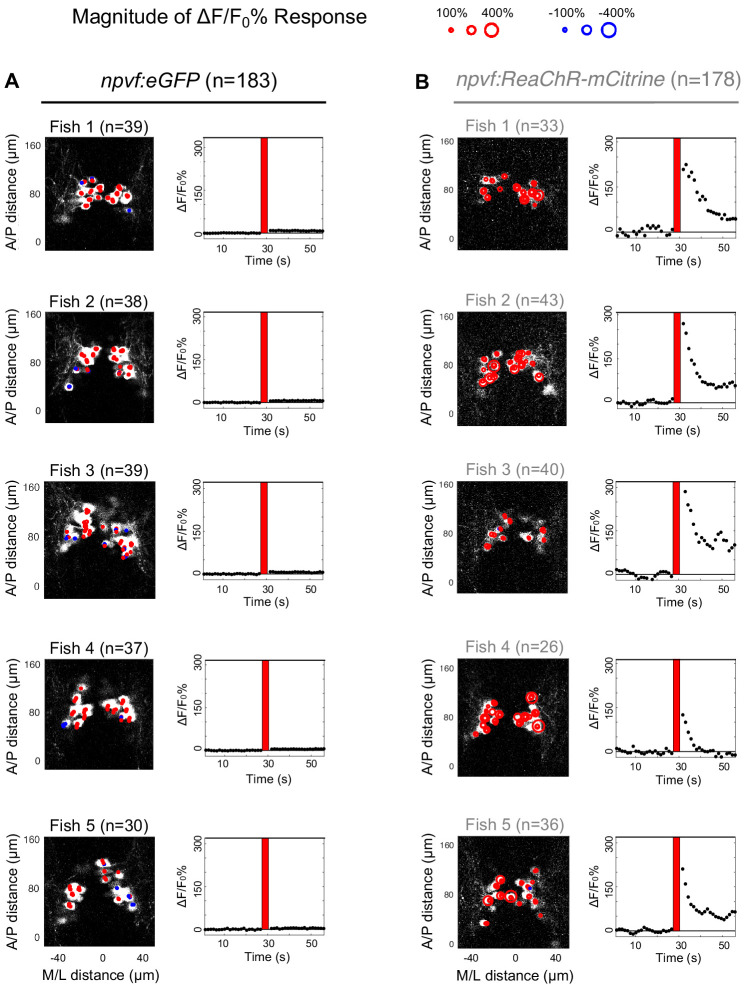
Responses of individual NPVF neurons to optogenetic stimulation of NPVF neurons in individual fish.6-dpf Tg(npvf:eGFP); Tg(npvf:GCaMP6s-P2A-tdTomato) (A) and Tg(npvf:ReaChR-mCitrine); Tg(npvf:GCaMP6s-P2A-tdTomato) (B) animals were analyzed for normalized GCaMP6s fluorescence levels in NPVF neurons pre- and post-optogenetic stimulation of NPVF neurons. Data from Figure 2—figure supplement 1 are displayed here as separate fish. Maximum intensity projection images (left) show GCaMP6s fluorescence averaged over the first 10 imaging frames post-stimulation and provide spatial information along the anterior/posterior and medial/lateral axes of the brain. Size of red or blue circle indicates magnitude of normalized GCaMP6s fluorescence increase or decrease, respectively, in response to optogenetic stimulation. Dot plots (right) show average normalized GCaMP6s fluorescence of all NPVF neurons for each frame before and after optogenetic stimulation (red line). A, anterior; P, posterior; M, medial; L, lateral. n = number of NPVF neurons imaged.